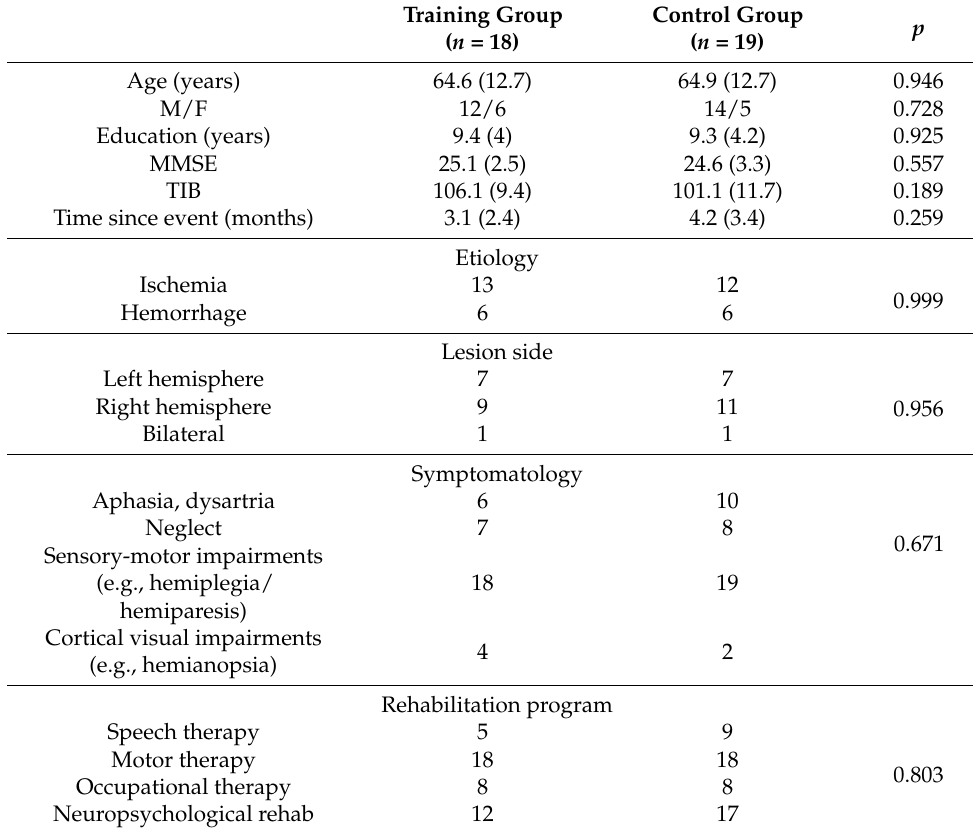
Table 1. Demographic characteristics of the two patients’ groups. Mean (and standard deviation) or frequencies are reported in cells. MMSE: Mini-Mental State Examination; TIB: Italian version of the National Adult Reading Test. P-values were obtained from independent sample t -tests (Age, Education, MMSE, TIB, and Time since event) or chi-square (M/F, Etiology, Symptomatology, and Rehabilitation program)